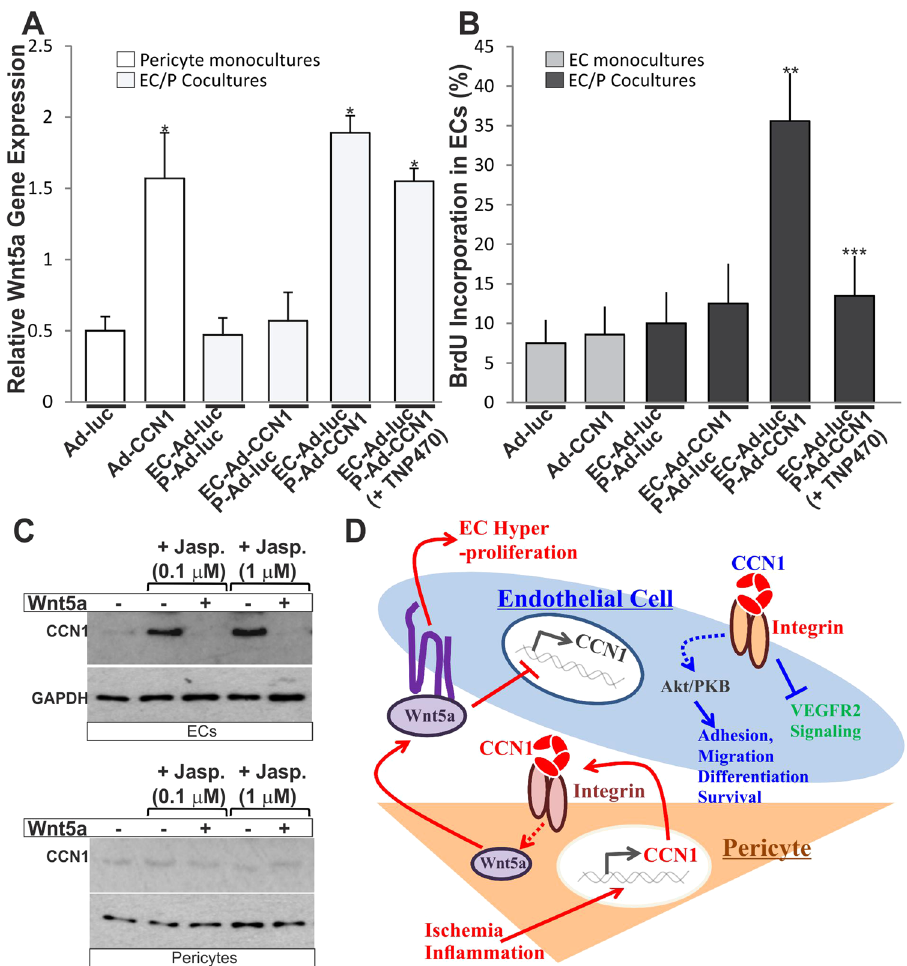
Figure 8. Regulation of EC proliferation and CCN1 gene expression by Wnt5a. ( A , B ) Monocultures and cocultures of ECs and pericytes (P) were transduced with either Ad-CCN1 or Ad-luc and further assessed for Wnt5a gene expression and BrdU incorporation in ECs. Cocultures of Ad-luc-infected ECs and Ad-CCN1- infected pericytes were incubated in the presence and absence of TNP470 (50 μ M). * p < 0.01 versus Ad-luc. ** p < 0.05 versus EC-Ad-CCN1 P-Ad-luc. *** p < 0.05 versus EC-Ad-luc P-Ad-CCN1. ( C ) Effects of Wnt5a on CCN1 gene expression on monolayer cell cultures of ECs and pericytes. Cultured ECs and pericytes were left untreated or treated with jasplakinolide for 2 h in the presence and absence of Wnt5a. CCN1 protein expression was determined by western immunoblotting. ( D ) Working model of the interplay between CCN1 and Wnt5a and their role in EC/pericyte crosstalk. Under ischemic conditions, EC/pericyte cooperation is altered by the shutdown of CCN1 in ECs and its expression by pericytes. Inasmuch as secreted CCN1 remains pericellular and acts largely on the cells that produce it, pericyte-derived CCN1 induces the expression of Wnt5a which acts in a paracrine manner to dampen CCN1 expression in ECs, stimulate their proliferation and promote retinal neovascularization. Thus, pericyte-derived CCN1 increases the sensitivity of ECs to